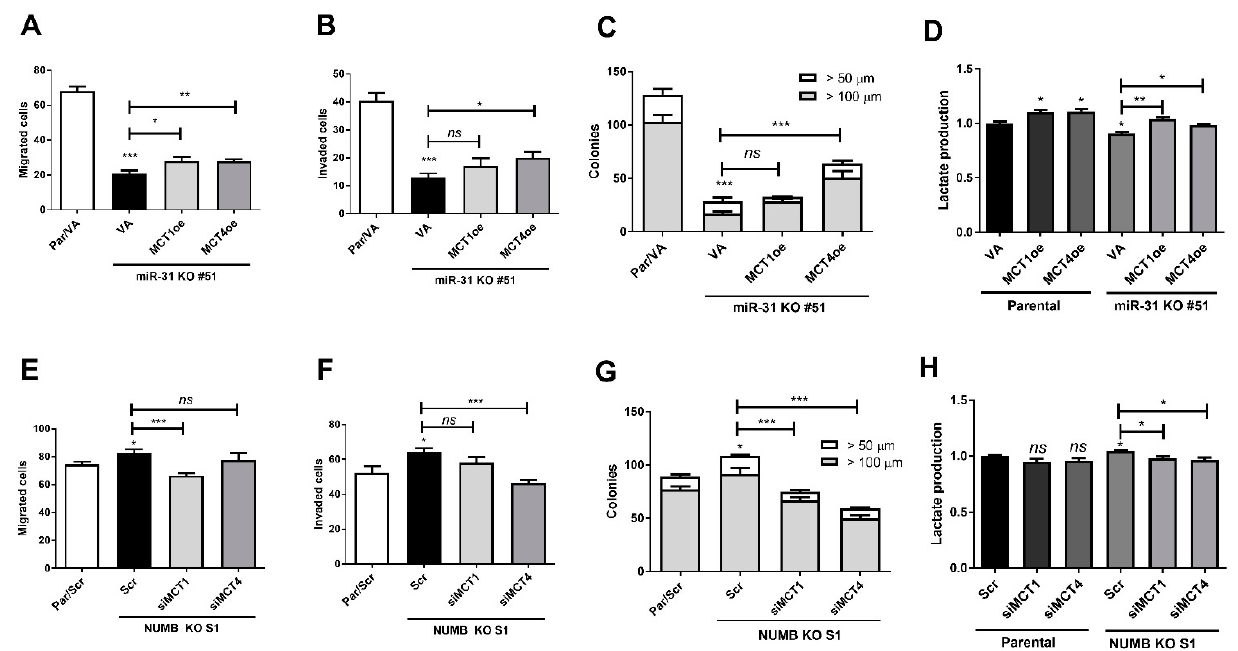
Figure 7. Reversal of miR-31 - NUMB -associated tumor phenotypes and lactate production by MCT1 and MCT4 . ( A – D ) SAS cell and SAS miR-31 KO#51 subclone. ( E – H ) SAS cells and SAS NUMB KO S1 subclone. ( A , E ) Migration assay. ( B , F ) Invasion assay. ( C , G ) Anchorage-independent colony formation. ( D , H ). Lactate production. The decreased oncogenicity and lactate production due to miR-31 deletion was partially reversed by exogenous expression of MCT1 or MCT4 . The increased oncogenicity and lactate production due to NUMB deletion was partially reversed by the knockdown of MCT1 or MCT4 expression. Scr, scramble oligonucleotide; VA, vector alone. ns , not significant; *, p < 0.05; **, p < 0.01; ***, p < 0.001.